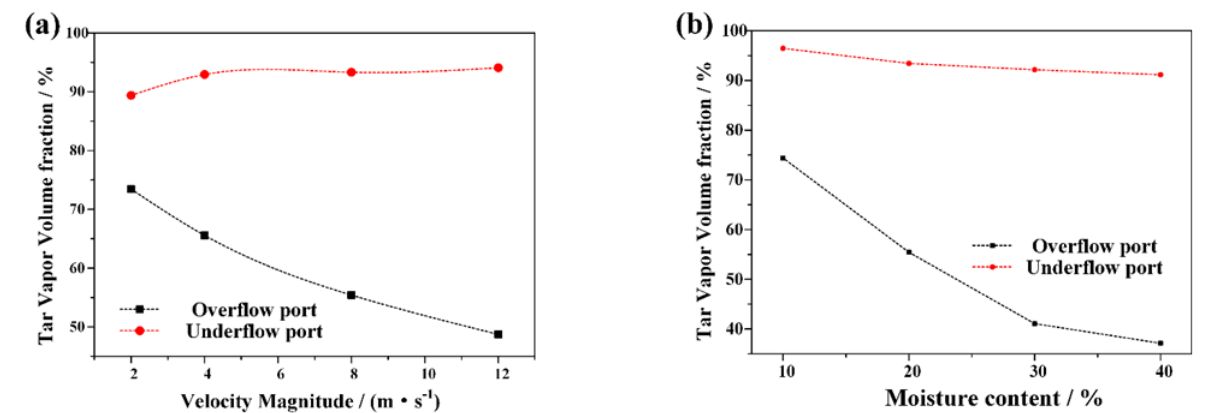
Figure 10. The separation efficiency of the cyclone. ( a ) At the overflow outlet and ( b ) at the under- flow outlet.